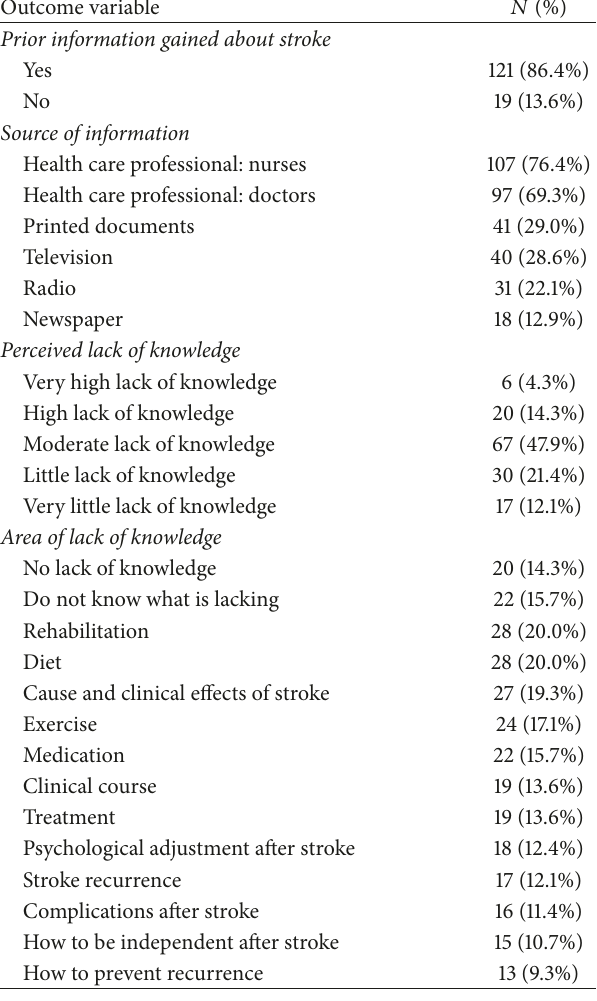
Table 2: Source of information, perception of knowledge, and area of lack of knowledge about